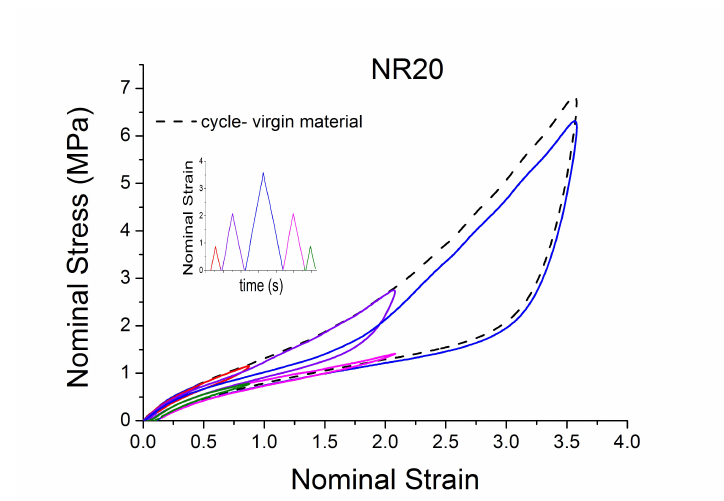
Figure 2. Stress–strain response of natural rubber filled with 20 phr of carbon black (NR20) when subjected to cyclic uniaxial tension. Different behaviour of the material after a different pre-strain is evident.